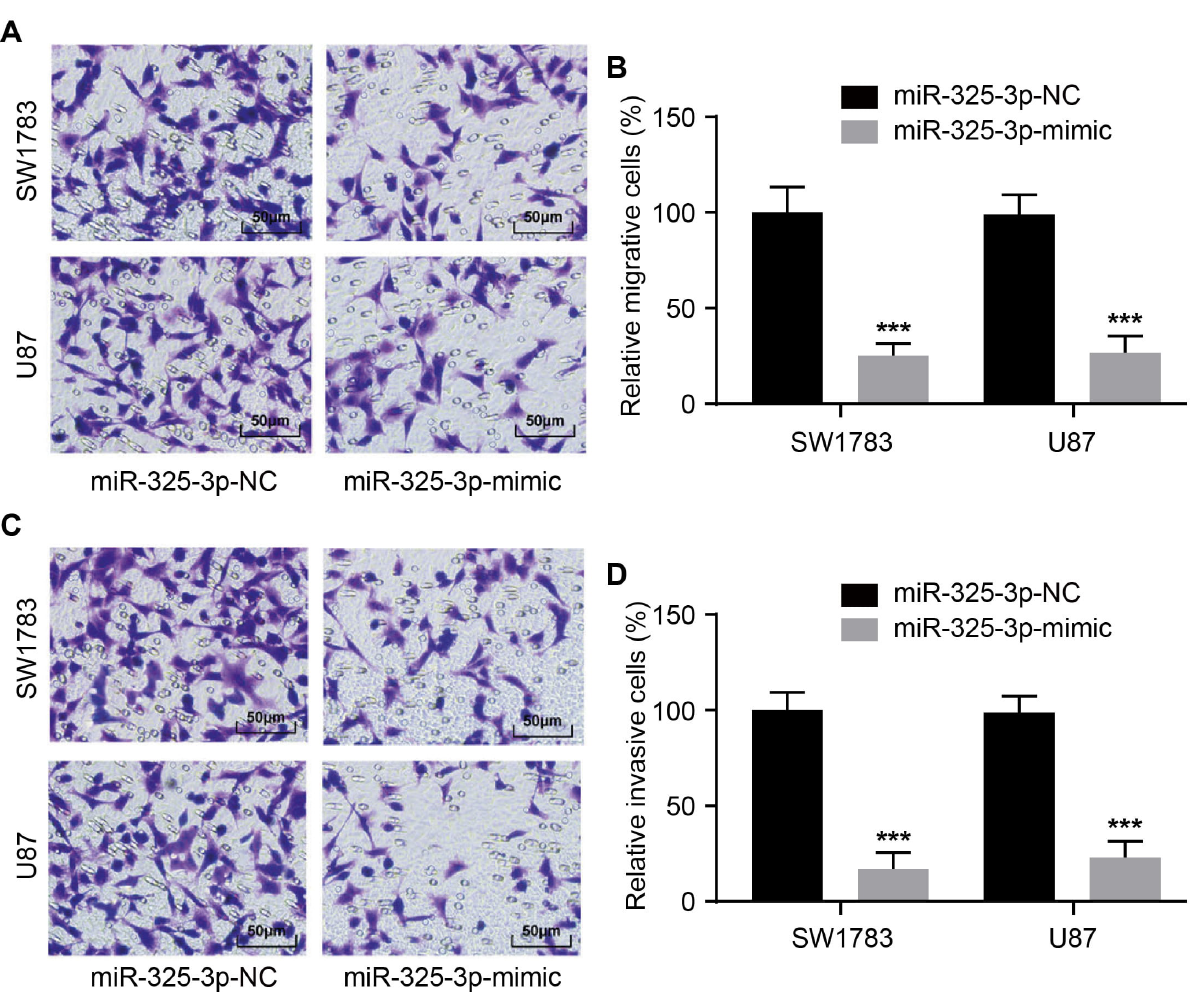
Fig. 4. Upregulation of miR-325-3p suppressed glioma cell migration and invasion. (A,B) Transwell assay revealed that upregulation of miR-325-3p decreasedthemigrationcapabilityofSW1783andU87cells. (C,D)TranswellassayrevealedthatupregulationofmiR-325-3pdecreasedtheinvasioncapability of SW1783 and U87 cells. Data are presented as the mean ± SEM, *** p < 0.001, compared to the miR-325-3p-NC